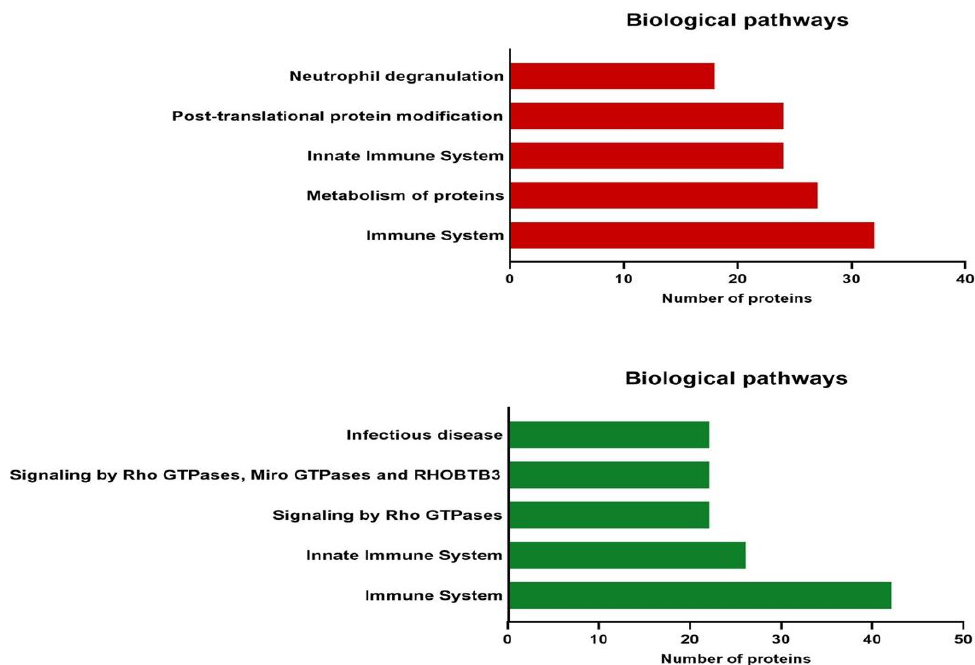
Figure 5. Top five biological pathways involving differentially expressed proteins of cervical cancer EVs. Graphical representation of main Reactome pathways enriched with upregulated (red bars) and downregulated (green bars) proteins with significant p -value < 0.05.